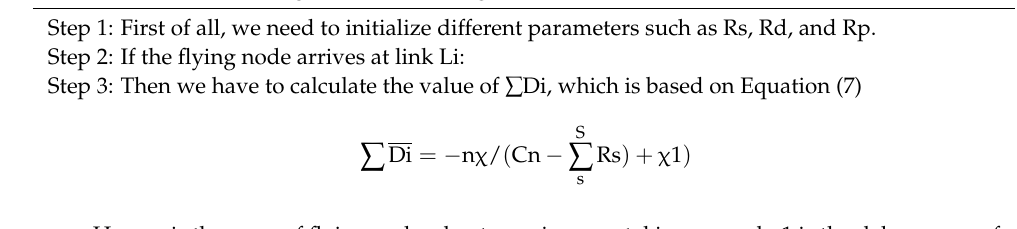
Algorithm 2. Traffic Congestion Control